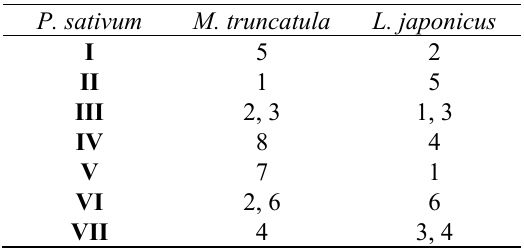
Table 2. Correspondence among pea linkage groups and M. truncatula and L. japonicus pseudochromosomes.